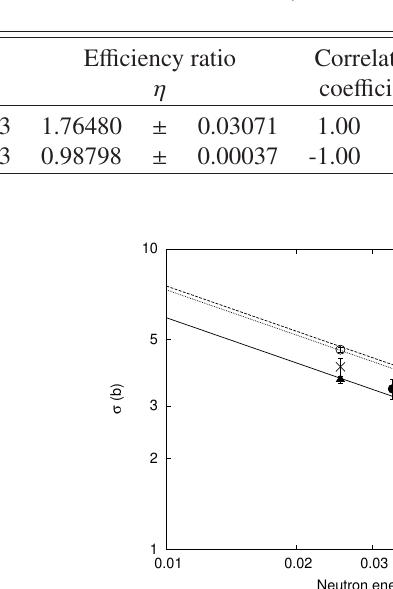
Table 2. E ffi ciency ratios η for the γ lines used for measurements of the 198 Au, 56 Mn and 72 Ga activities [18].